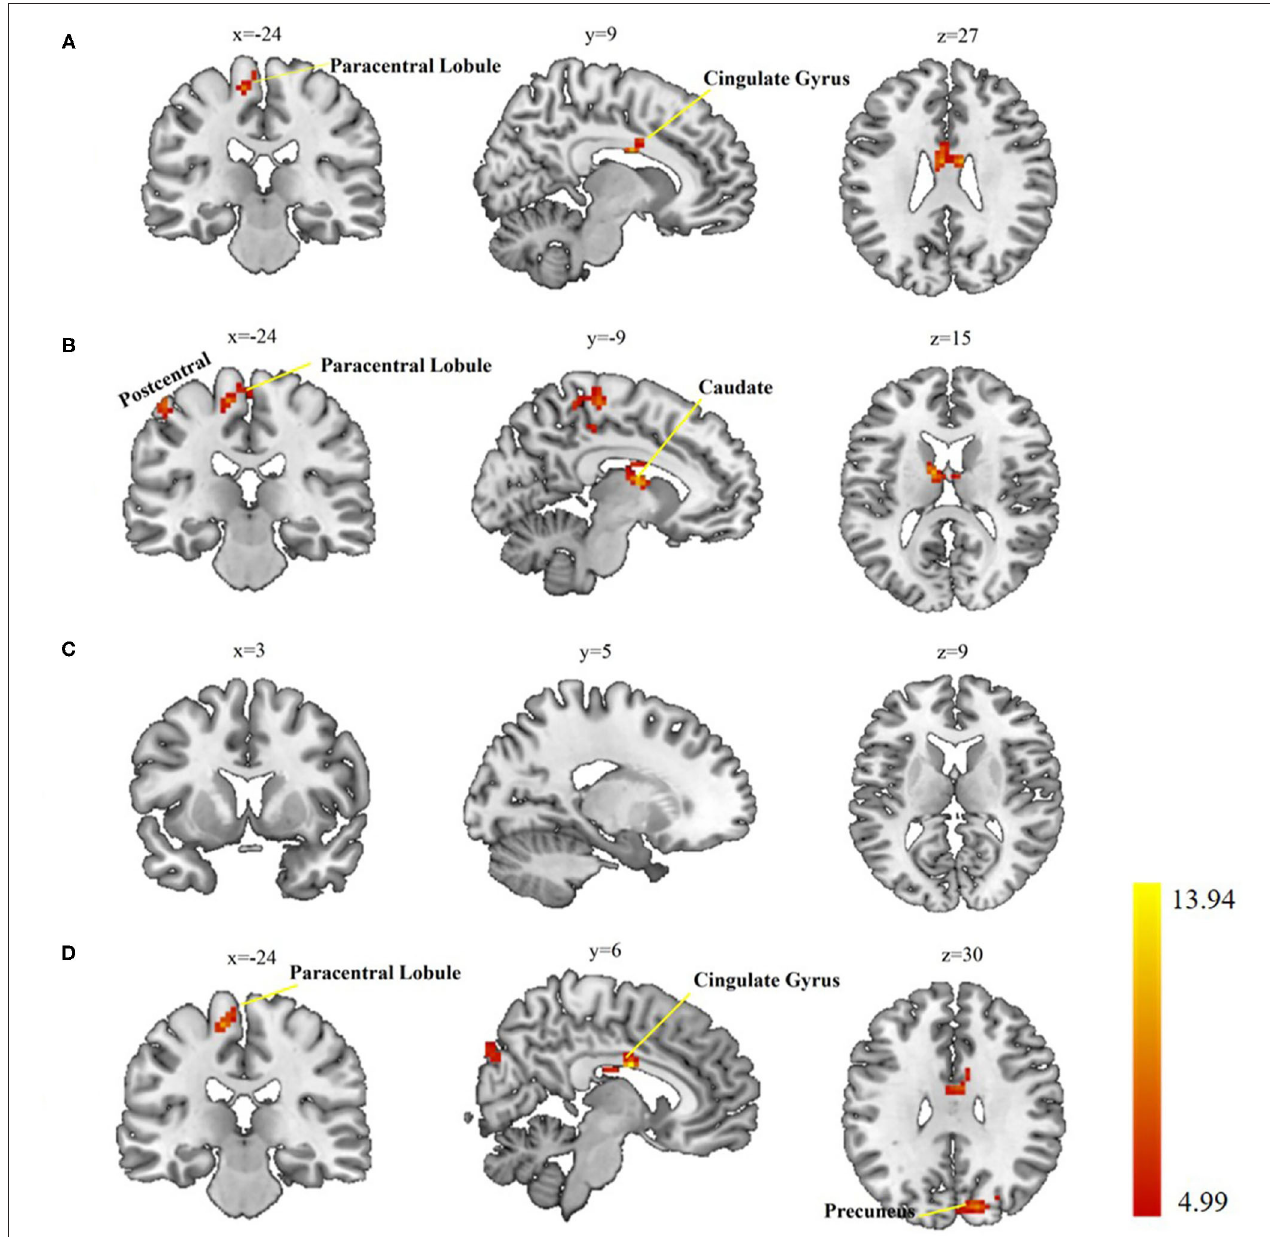
FIGURE 2 | Group differences in seed-based functional connectivity (FC). (A) Significant regions based on left postcentral seed; (B) significant regions based on right postcentral seed; (C) significant regions based left precentral seed; (D) significant regions based on right precentral seed. Gaussian Random Field (GRF) theory correction with voxel level p < 0.01 and cluster level p <